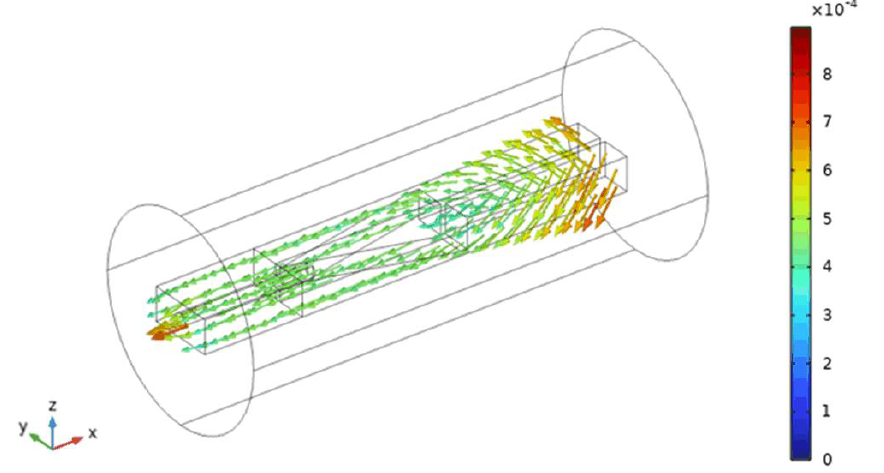
Figure 17. The flow velocity and flow direction of blood around the micro-stirrer end-effort.